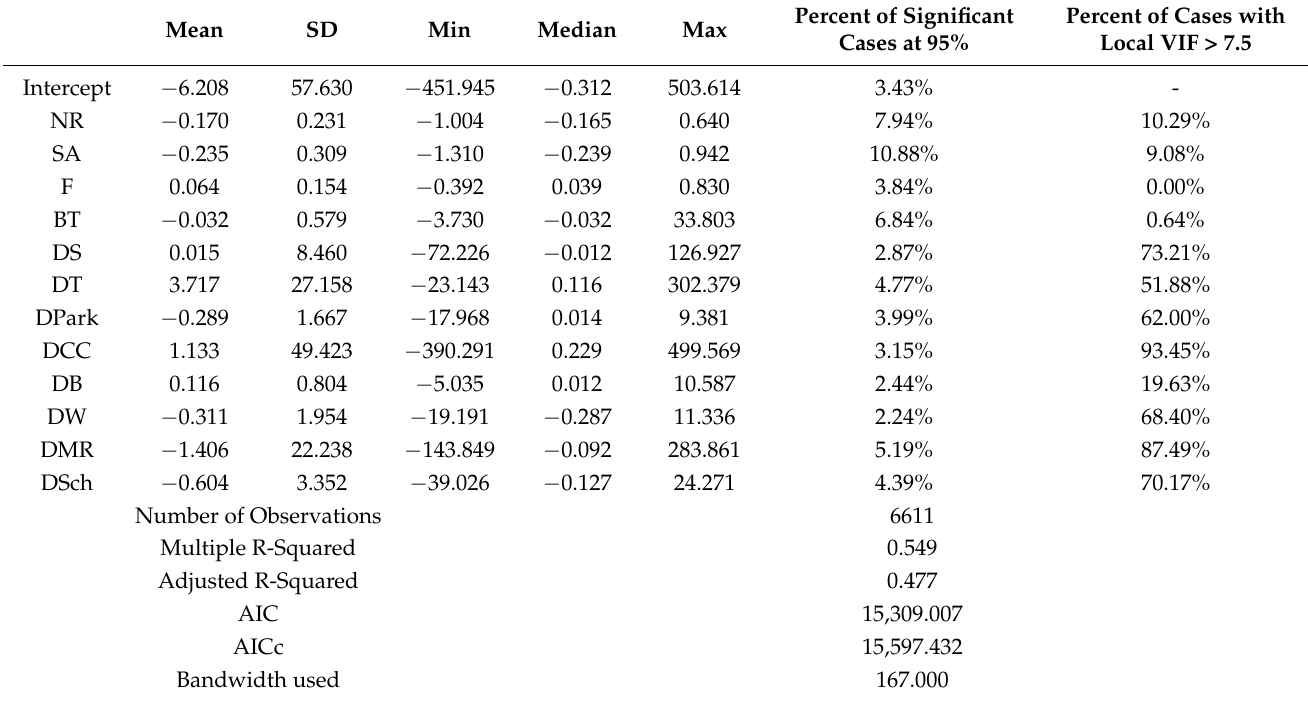
Table 7. Summary of squares (GWR) regression results (Group